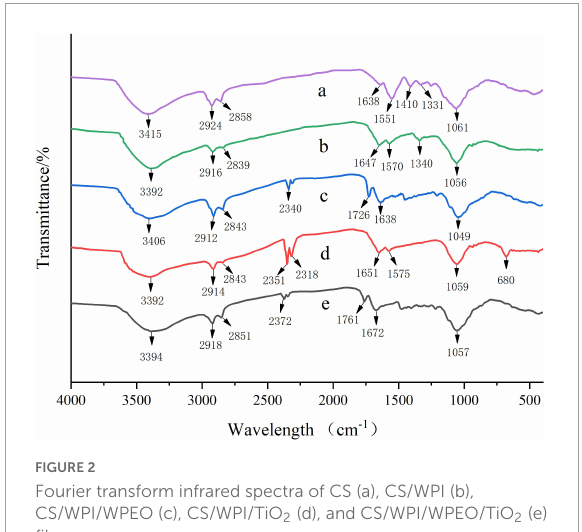
FIGURE2 Fourier transform infrared spectra of CS (a), CS/WPI (b), CS/WPI/WPEO (c), CS/WPI/TiO 2 (d), and CS/WPI/WPEO/TiO 2 (e)